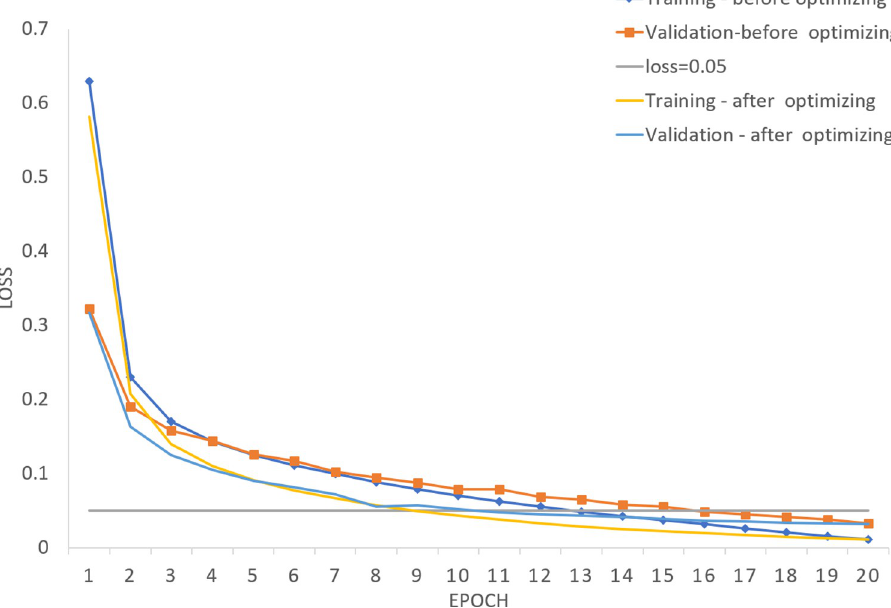
Fig 4. The losses of the training process before and after the optimization of loss function. A blue and an orange dot lines represent losses of training and validation set before optimization, whereas a yellow and a light blue lines represent losses of training and validation set after optimization. A gray line is the line when loss =